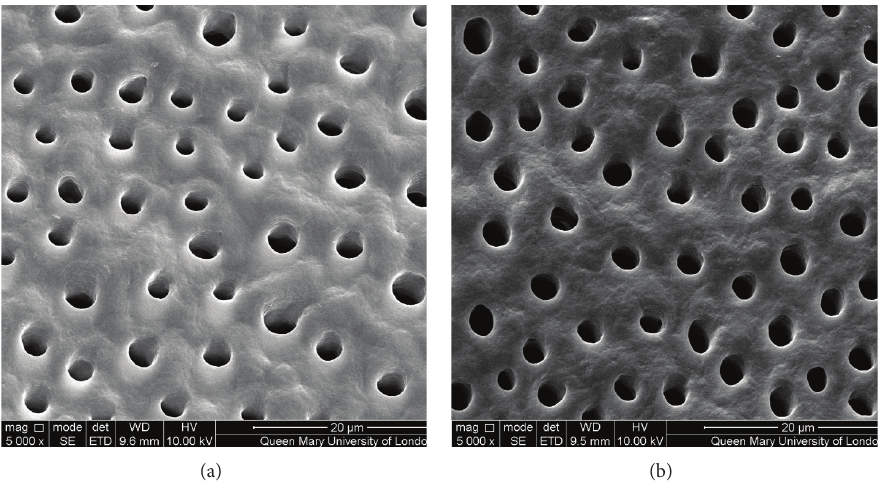
Figure3:SEMimagesofdentinetubulestreatedwitharginineandPVM/MAcopolymeroralrinse(ColgateSensitivePro-ReliefMouthwash), before treatment (a) and after treatment (b).